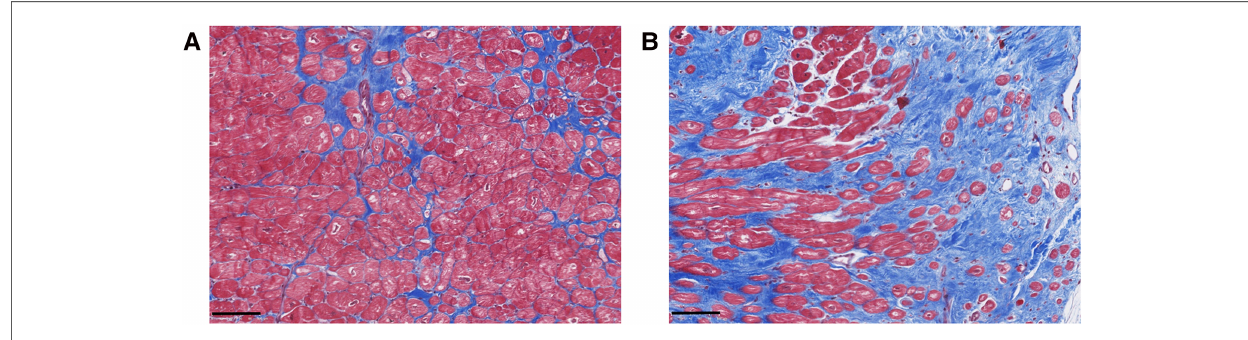
FIGURE 1 Exemplary histological analyses of Masson ’ s trichrome stained cardiac biopsies of the inferobasal region of the left ventricular wall in MVP patients undergoing mitral valve repair surgery. Advanced interstitial fi brosis ( A ) and replacement fi brosis ( B ) can be detected. Scalebars=100